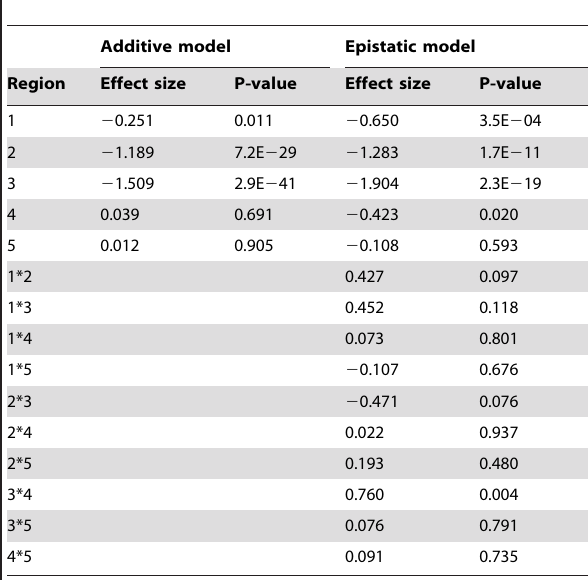
Table 1. Estimated effects of FZF1 divergence on sulfite